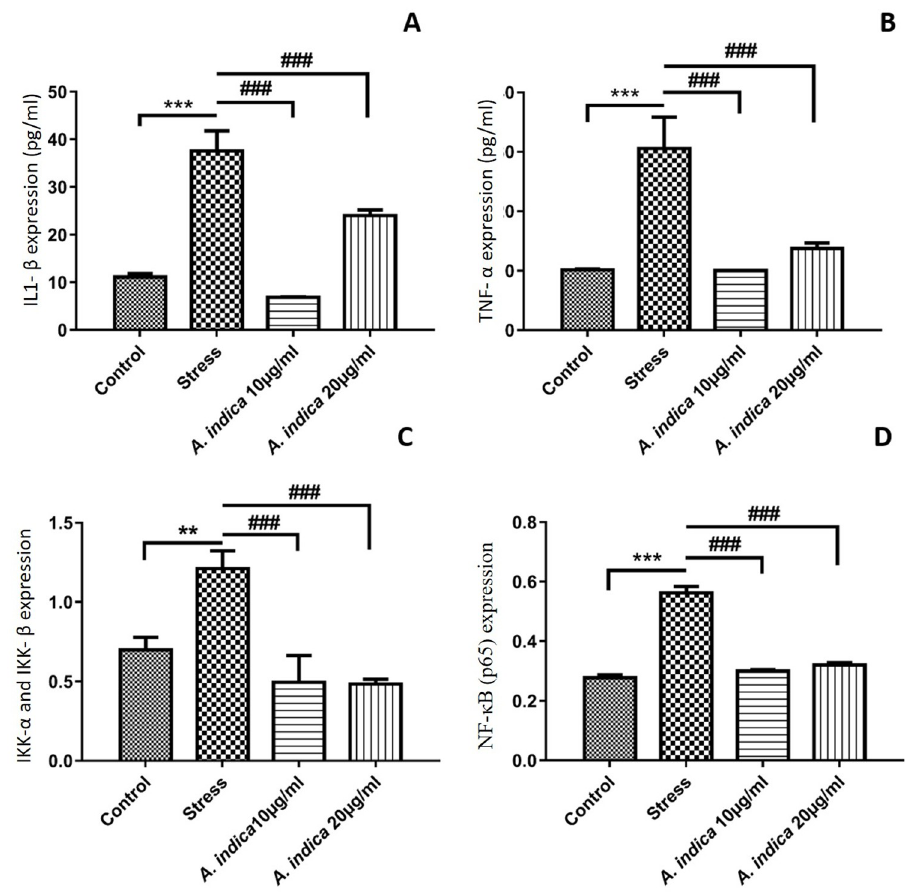
Fig 6. A . indica affected the proinflammatory cytokines production and NF- κ B transcription factors protein expression. Protein expression levels of (A) IL-1 β (B) TNF α (C) IKK α and β and (D) NF- κ B p65 were determined by ELISA. Values are statistically significant at p � < 0.05, p �� < 0.01, p ��� < 0.001compared with the control group while p# < 0.05, p## < 0.01, p### < 0.001 compared with stress group. The experiment was carried out in triplicates (n =